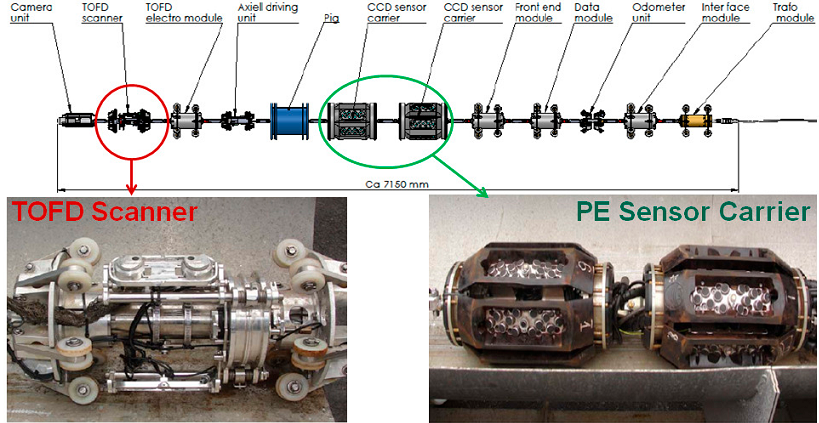
Figure 18. Setup of the 10° tethered inspection tool ( top ). (Lower left ) TOFD scanner; (Lower right ) Sensor carrier for pulse-echo